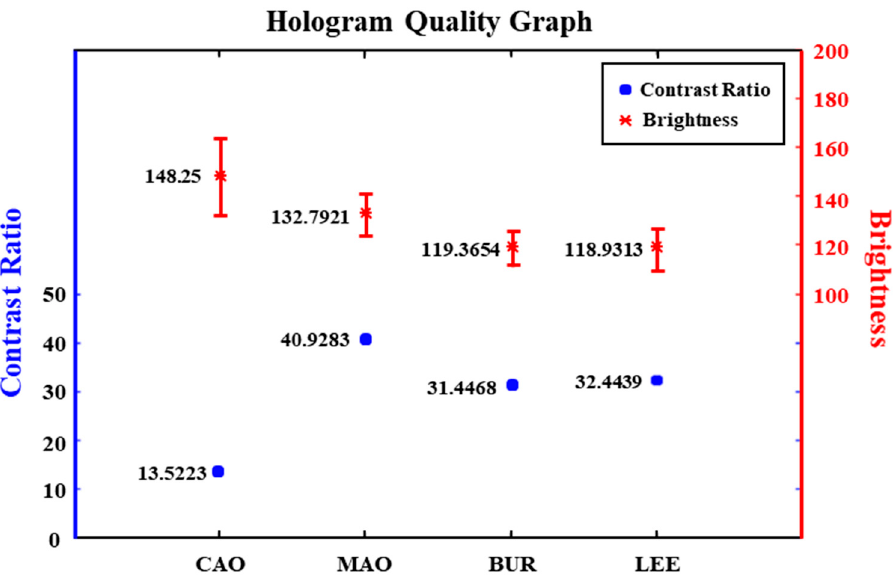
Figure 13. Diagram to plot holographic contrast ratio (HCR) and brightness analyzed from each scanned bright area on images of optical H3D reconstructions with respect to four different encodings. Blue color of the left vertical axis corresponds to data for contrast ratio, and red color of the right vertical axis corresponds to data for brightness.